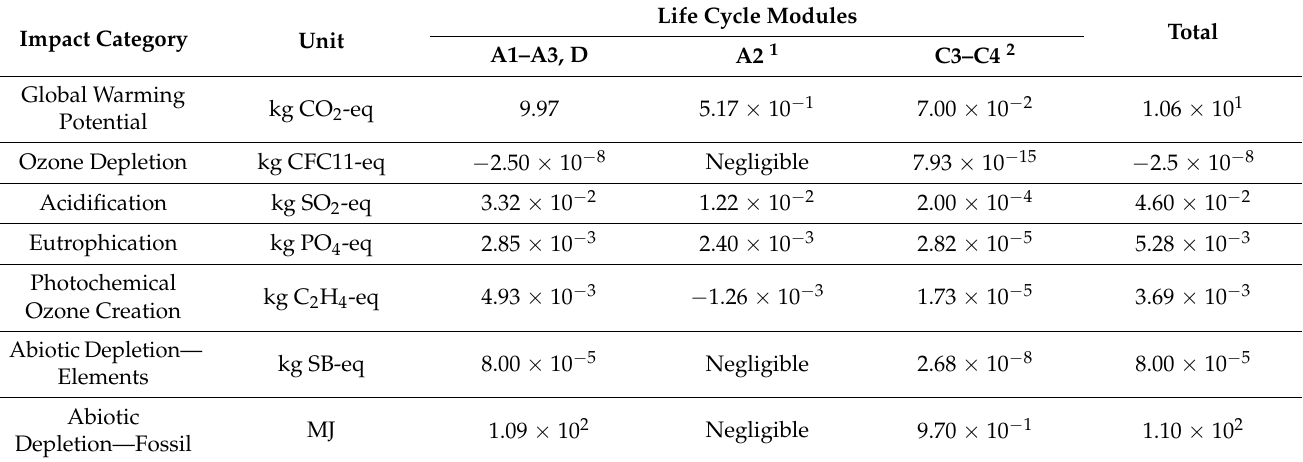
Table 3. Overall life cycle impact for the seven impact categories for 1 m 2 of case steel roofing. Life Cycle